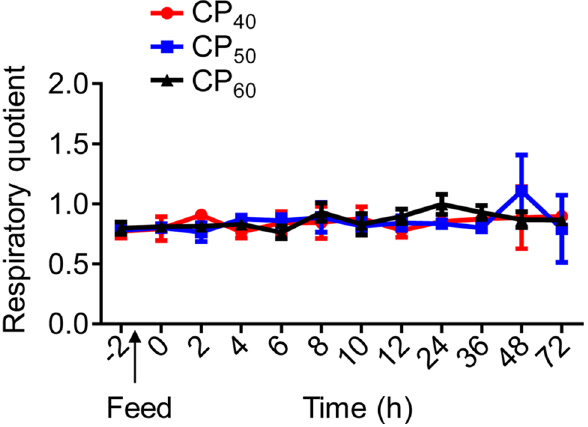
Figure 6. Respiratory quotient (RQ) in juvenile Sagmariasus verreauxi . Lobsters were reared at 21 °C and fed 15 N-labeled feeds at 1.5% body weight at three crude protein levels: 40%, 50% and 60%, corresponding to CP CP 50 and CP 60 treatments, respectively. The RQ at − 2 h indicates the routine RQ. The first post-prandial RQ was recorded at 0 h. All data represent mean ± standard error (SE) of 5 to 6 individuals.